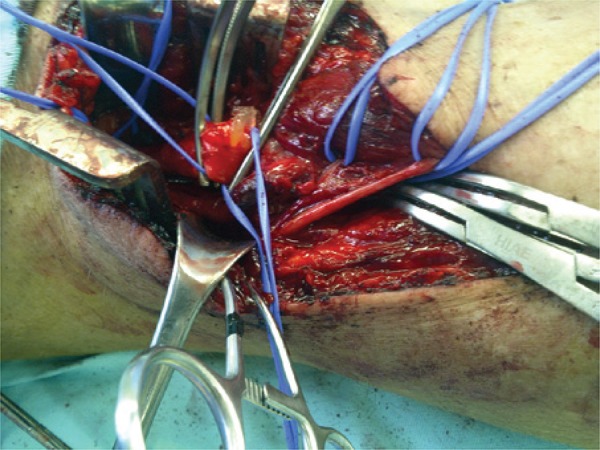
Secção da artéria. Saída de material gelatinoso